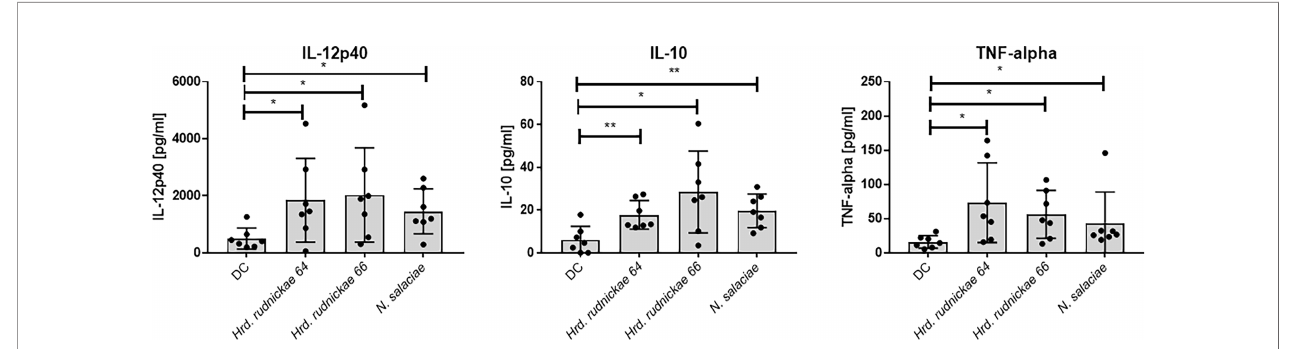
FIGURE 2 | Cytokine secretion by halophile-stimulated DCs. Human DCs were stimulated either with Hrd. rudnickae 64 , Hrd. rudnickae 66 , N. salaciae or were left unstimulated (DC) for 24h. The levels of IL-12p40, IL-10 and TNF- a secretion by stimulated DCs were measured in duplicates by ELISA. Data shown represent the means ± SD of 7 donors. Statistical analyses were performed using the Mann – Whitney U test for unpaired data. *p < 0.05; **p < 0.01 versus control (unstimulated DC).